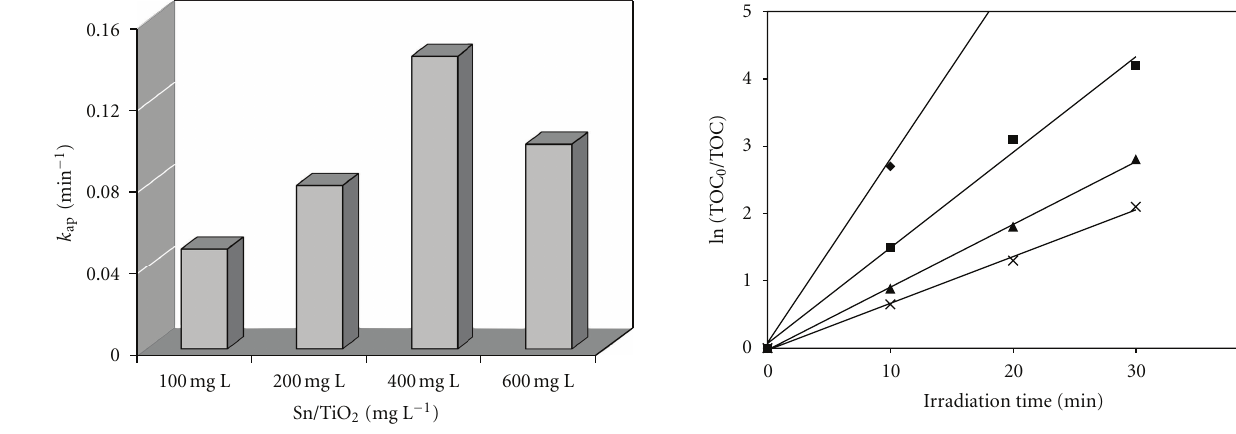
Figure 9: E ff ect of Sn/TiO 2 amount on AMOX mineralization.